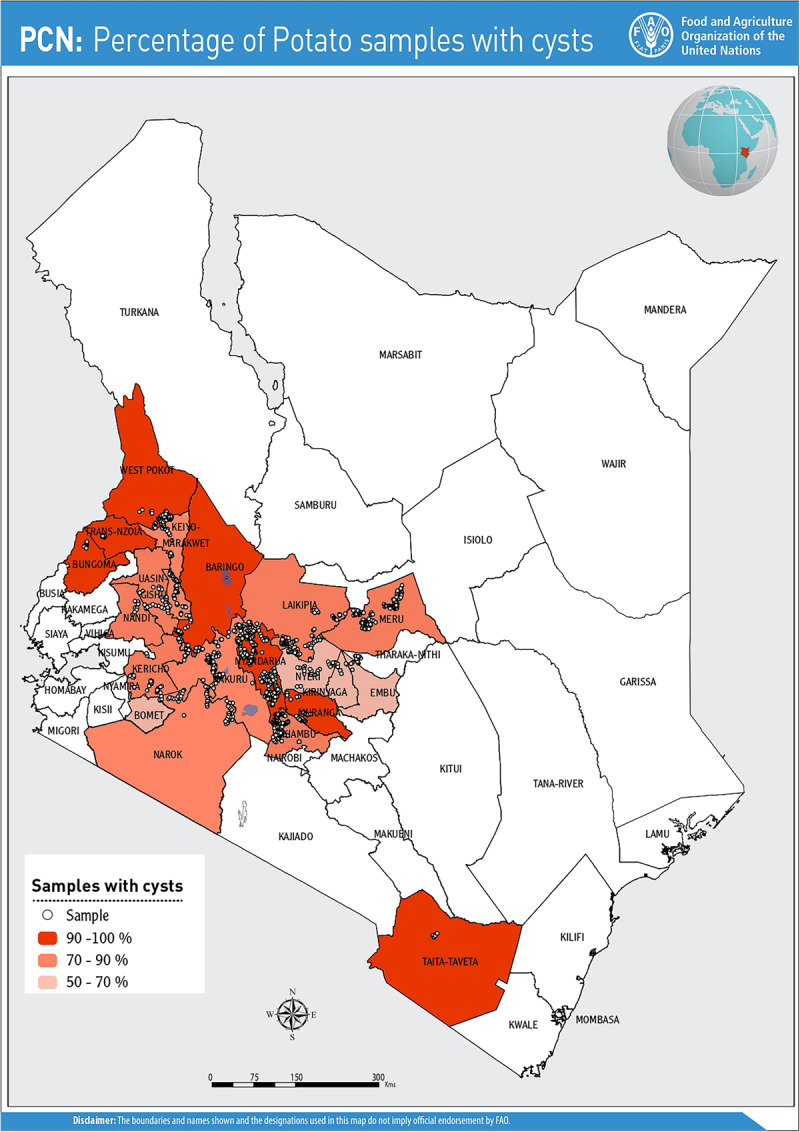
PCN distribution and incidence level classification across the 20 counties in Kenya.